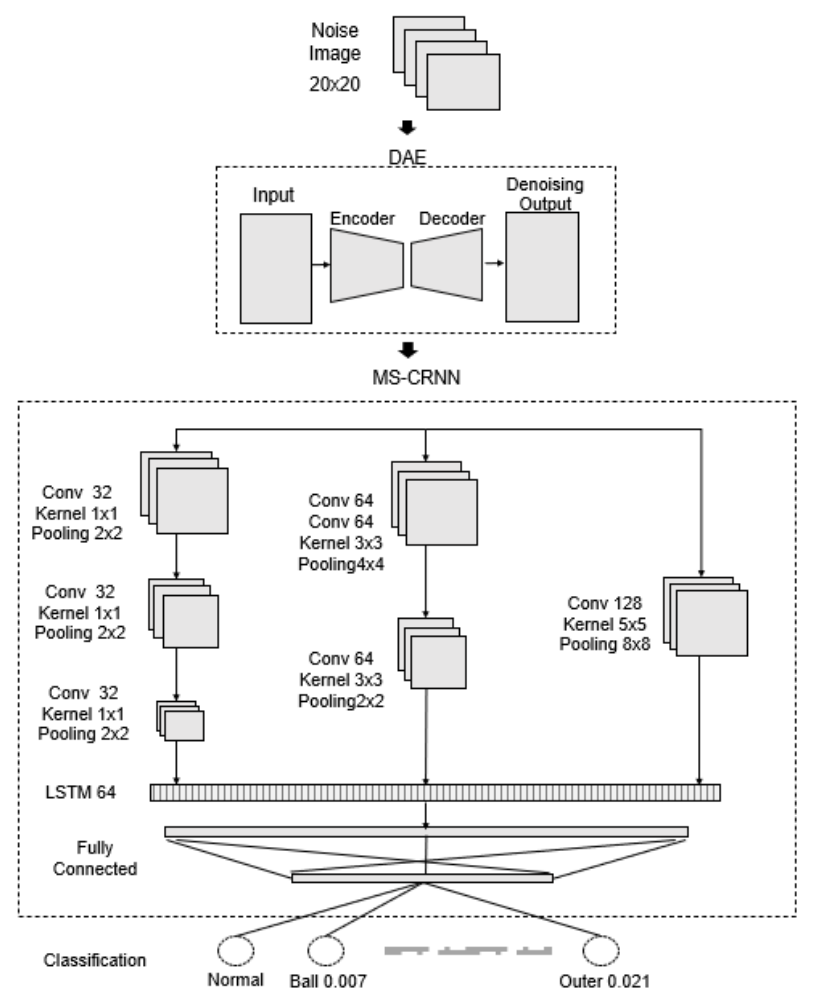
Figure 6. Architecture of the DAE + MS-CRNN.